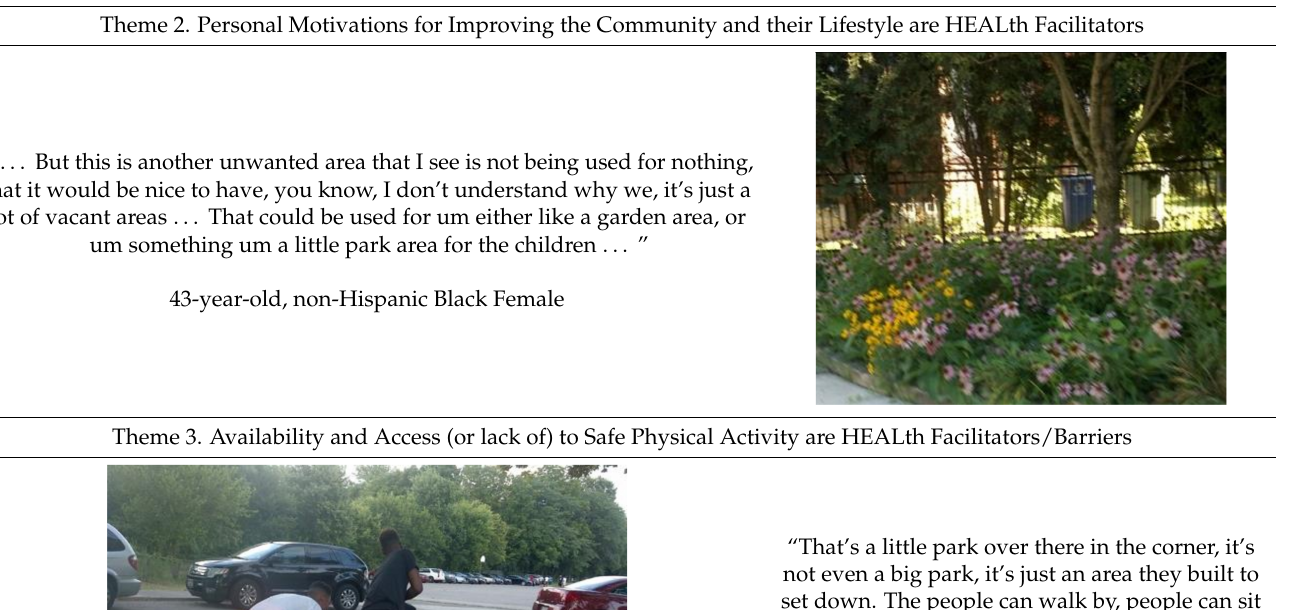
“ . . . A lot of them from mid-Ohio, I’ve noticed a lot of the bigger community centers are using that Mid Ohio Foodbank that comes and delivers a lot of that produce. But there is a lot of, in this area, places that do that. Even the school do that, promoting healthy eating . . .